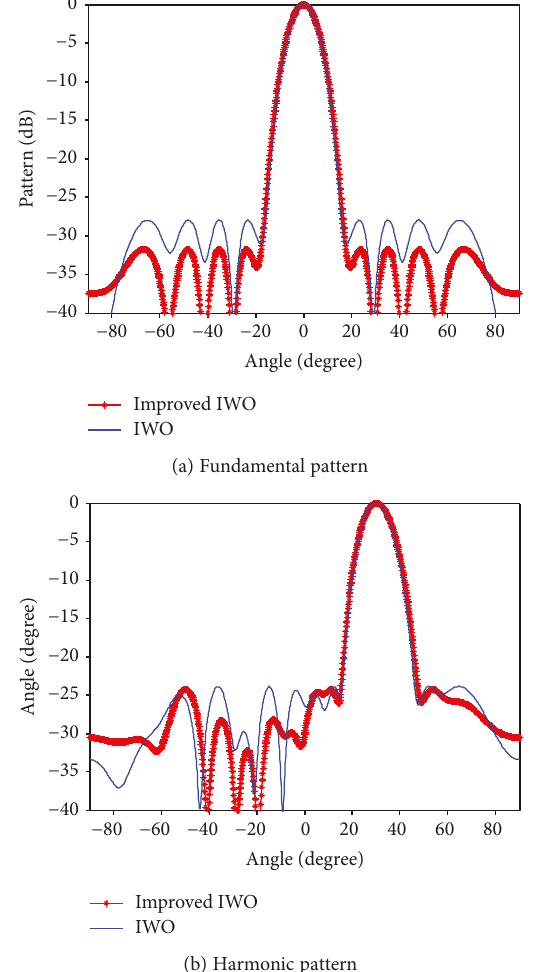
Figure 7: Rational patterns obtained by the IWO and PSO-IWO